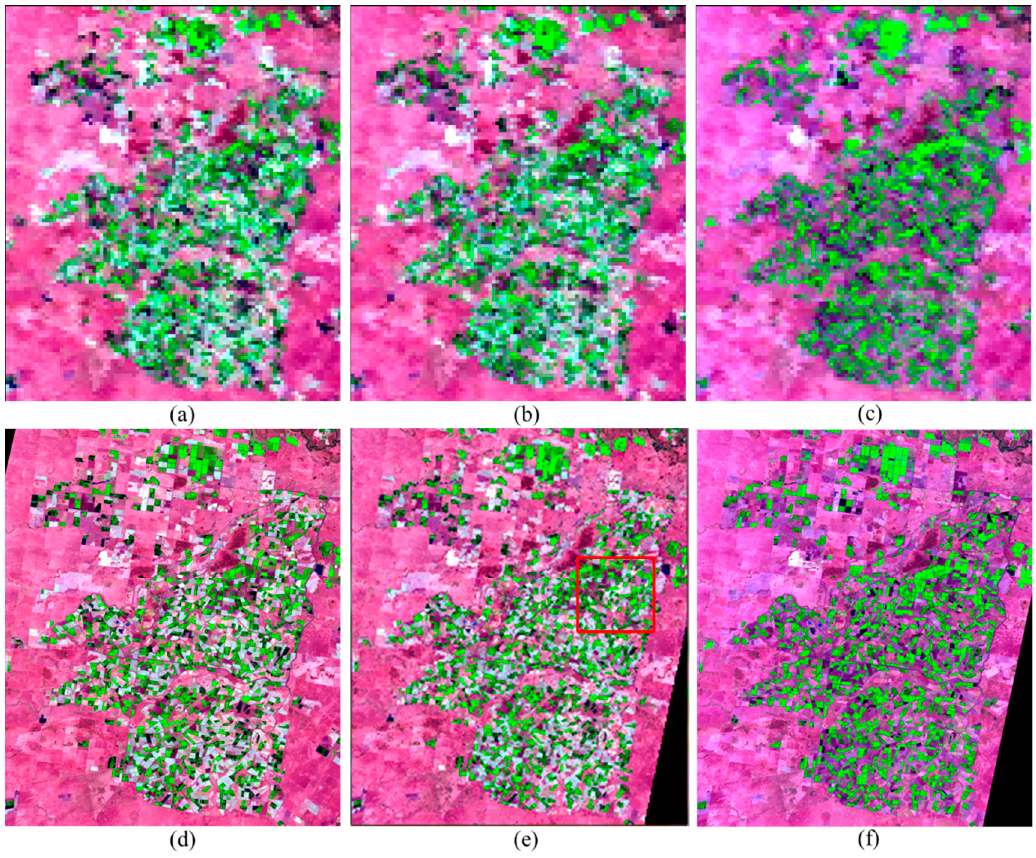
Figure 6. Illustrating image-pairs of CIA. ( a – c ) are MODIS data on the 7th, 8th, and 9th dates, respectively; ( d – f ) are the Landsat data on the same dates as MODIS.